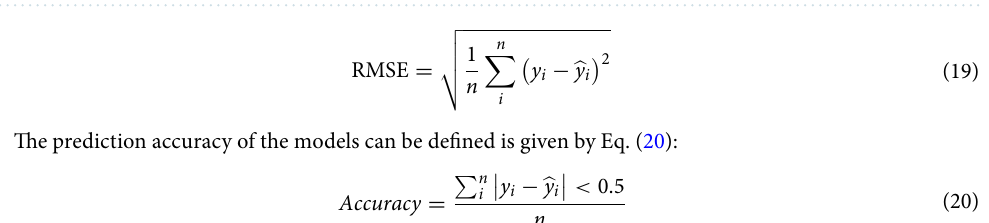
Figure 6. System overview showing the training phase of the models, the input image datasets were partitioned into 80% for the training and 20% for validation or